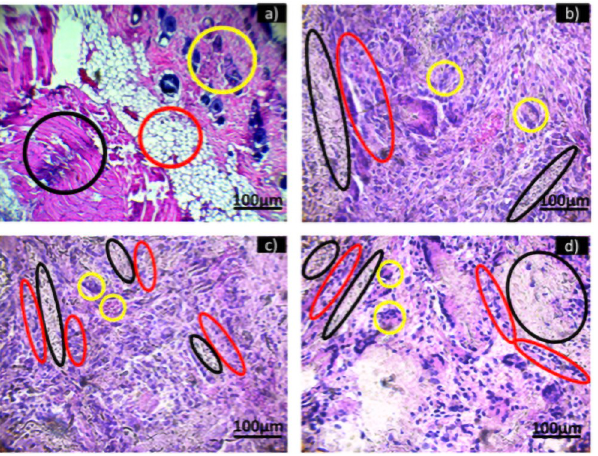
Fig 9. Histological sections at 400 X: a) Control and exposed to HA-SiO 2 for b) two, c) four and d) six weeks.